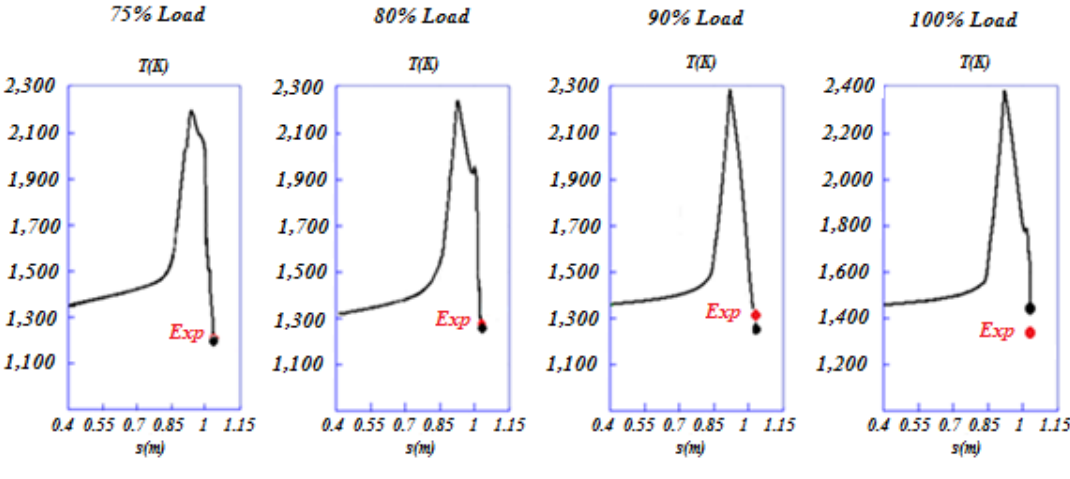
Figure 12. Comparison between numerical and experimental temperatures at different load